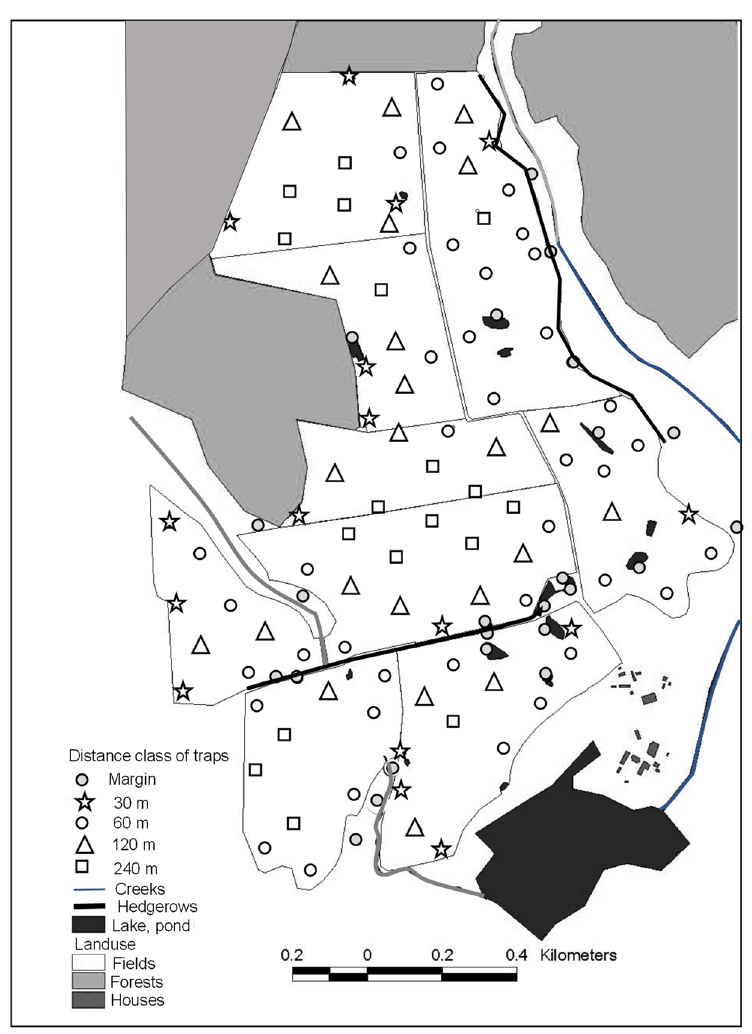
Figure 1. Map of the study fields with grid and distance classes of pitfall